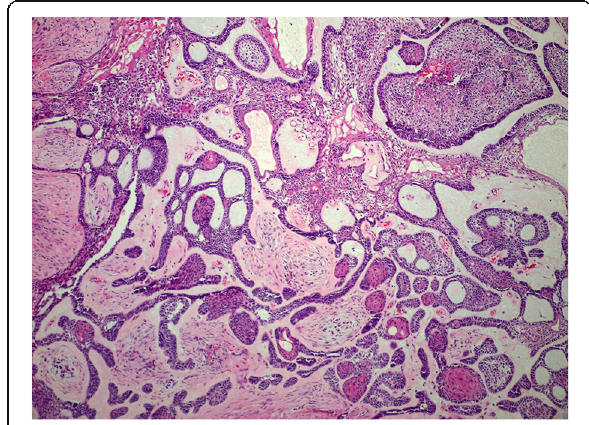
Fig. 2 Conventional ameloblastoma presenting multiple patterns: plexiform, follicular and acanthomatous (Original Magnification × 100)